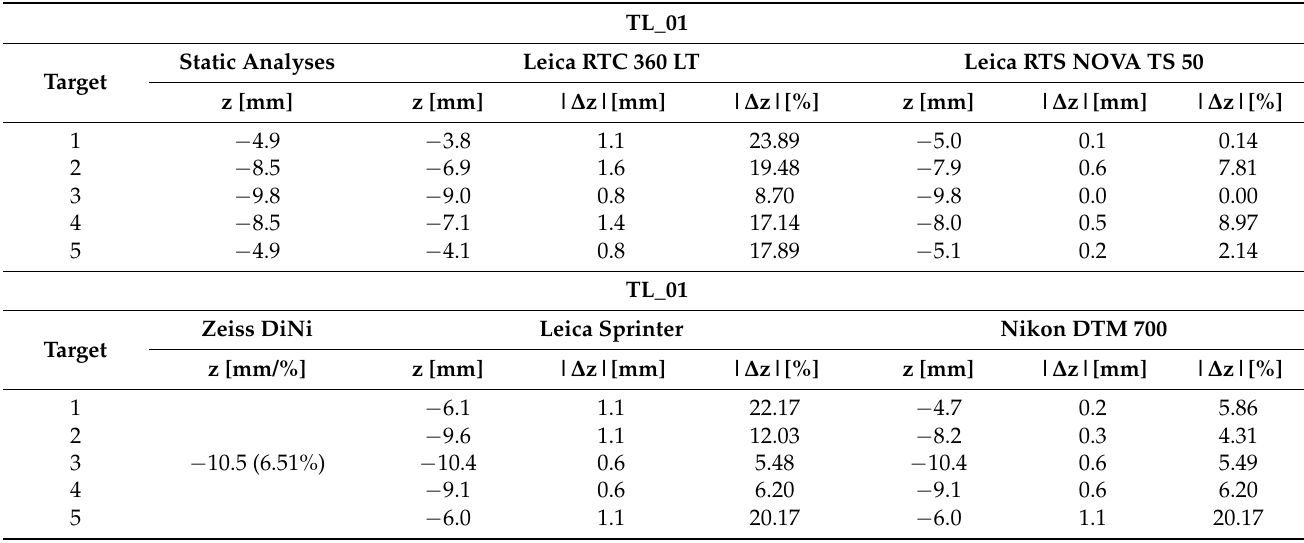
Table 3. Differences and comparisons of measurements with static analyses of the beam TL_01.